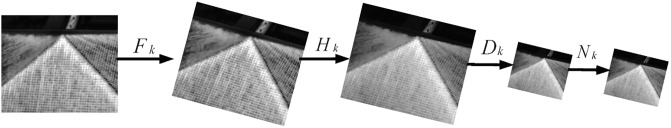
Thermal IR imaging model.